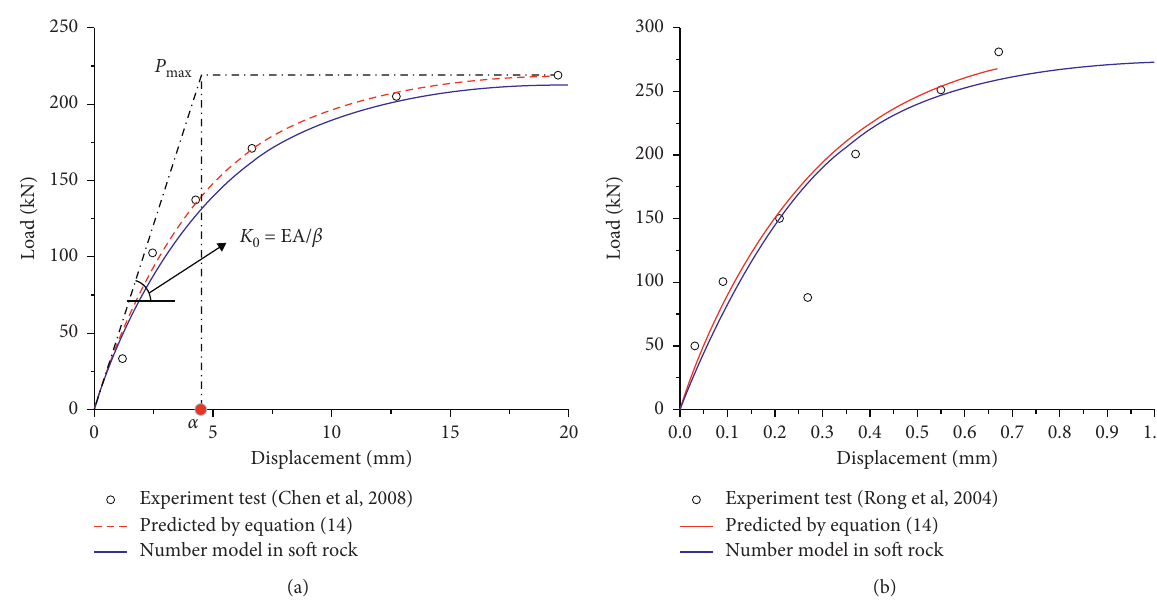
Figure 5: Comparison of load-displacement curves between the analytical model predicted by equation (14), the numerical model, and the experiment test in (a) soft rock and (b) hard rock.